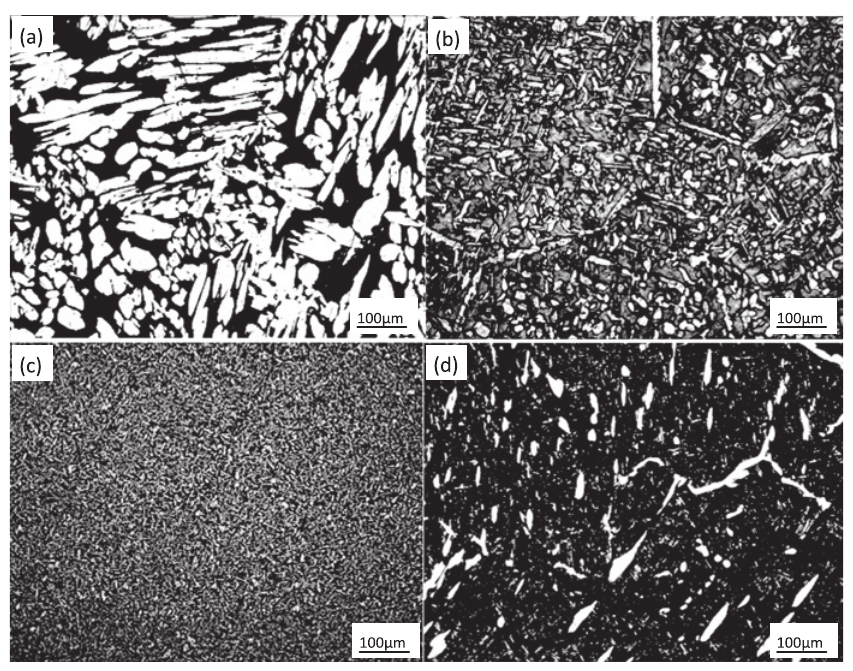
Fig. 1: Microstructures of the CuZn alloy. (a) Original; (b) after 1 GPa treatment; (c) after 3 GPa treatment; (d) after 5 GPa